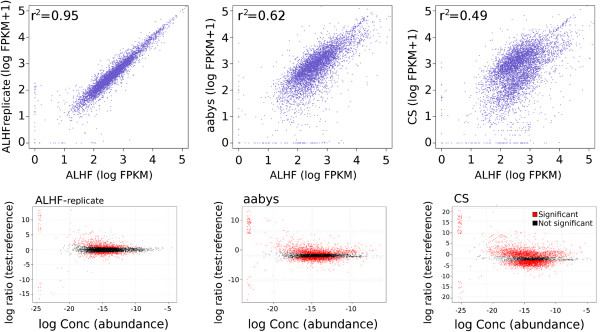
Correlation of the gene expression levels (FPKM) for all of the Musca domestica strains tested versus the ALHF pyrethroid-resistant strain (upper panels). Scatterplots represent the differential gene expression compared to the ALHF strain (lower panels). In the upper panels, the points closest to the 1:1 line represent genes with the same gene expression value as the ALHF strain and the tested M. domestica strain. In the lower panels, each point represents a gene, with red points below the central axis indicating the genes that were down-regulated in the tested M. domestica strain compared to the ALHF strain, thus the red points below the horizontal axis on the lower panels represent the genes that were up-regulated in the pyrethroid-resistant ALHF strain and putatively linked to insecticide resistance.